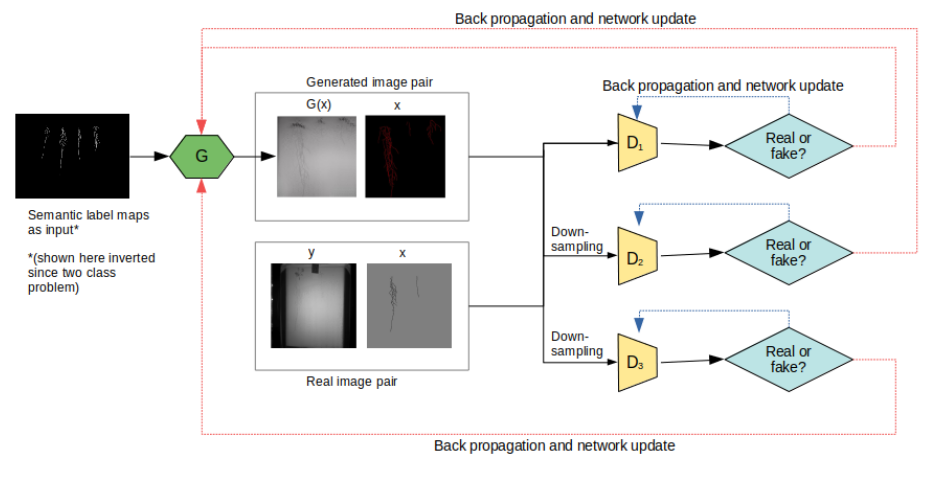
Figure 4. Pix2PixHD